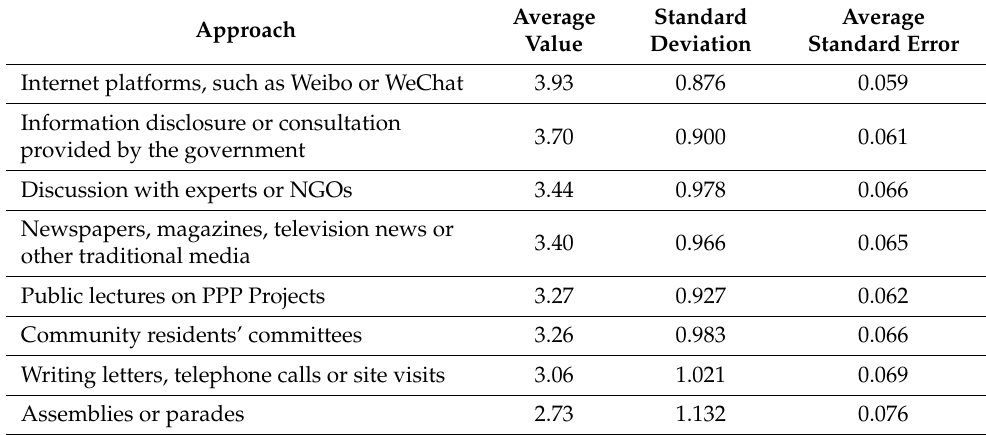
Table 8. Eight approaches of public participation in PPP